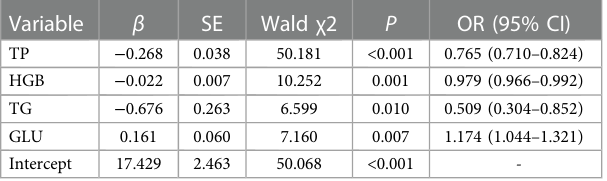
TABLE 2 Multivariate logistic regression analysis for malnutrition in patients with heart failure. Variable